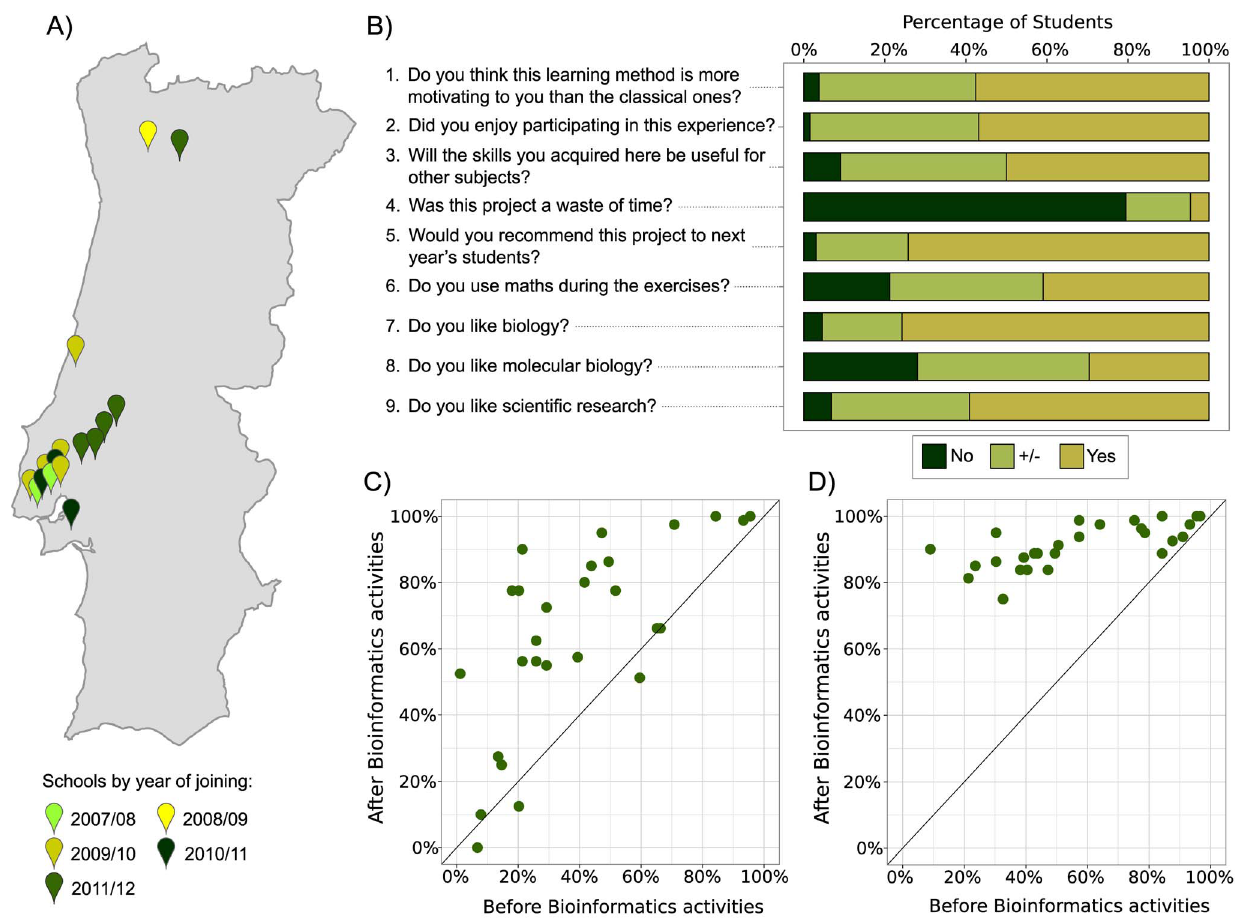
Figure 2. Schools and evaluation. ( A ) Map of schools participating, coloured by year of joining the project. ( B ) Summary of responses to confidential questionnaire. ( C ) Knowledge acquisition—each dot represents one class and the average score that students in that class achieved in the test before and after finishing the ‘‘Vision’’ project. ( D ) Confidence—each dot represents one class and the percent of answers that students in that class answered True or False, as opposed to answering ‘‘I don’t know,’’ before and after finishing the ‘‘Vision’’